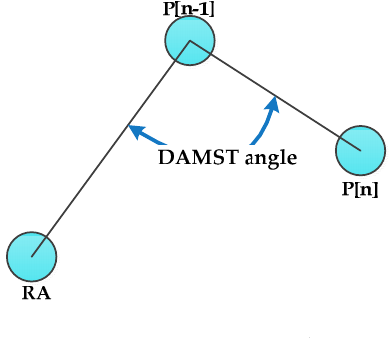
Figure 2. A DAMST angle.